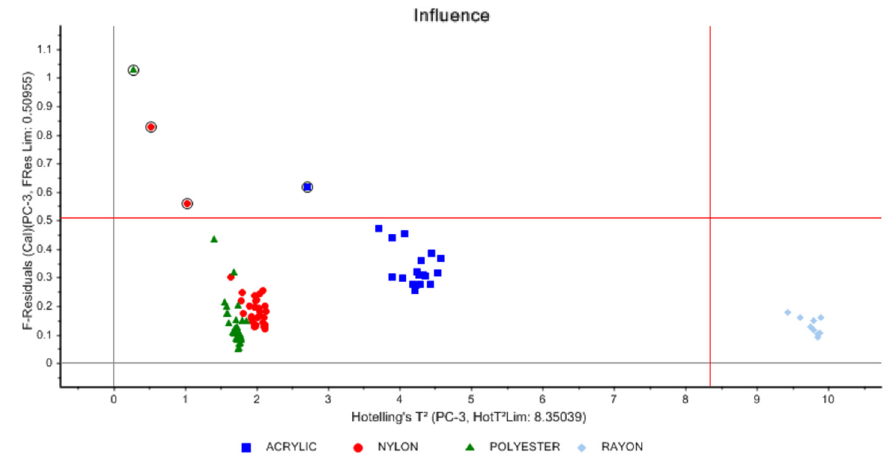
Figure 6. Influence plot.